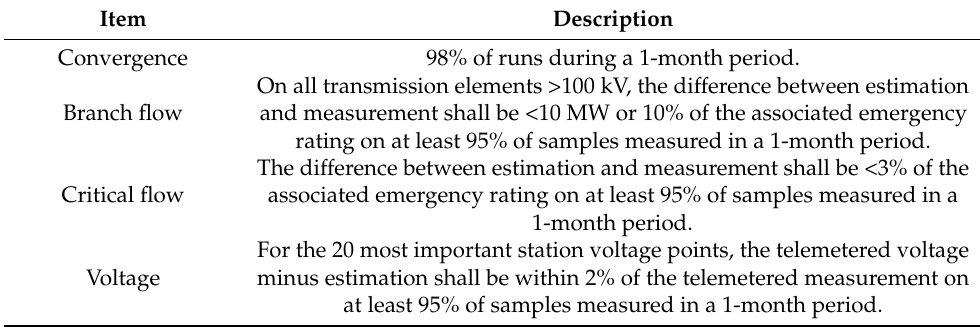
Table 16. State estimation performance requirements of ERCOT